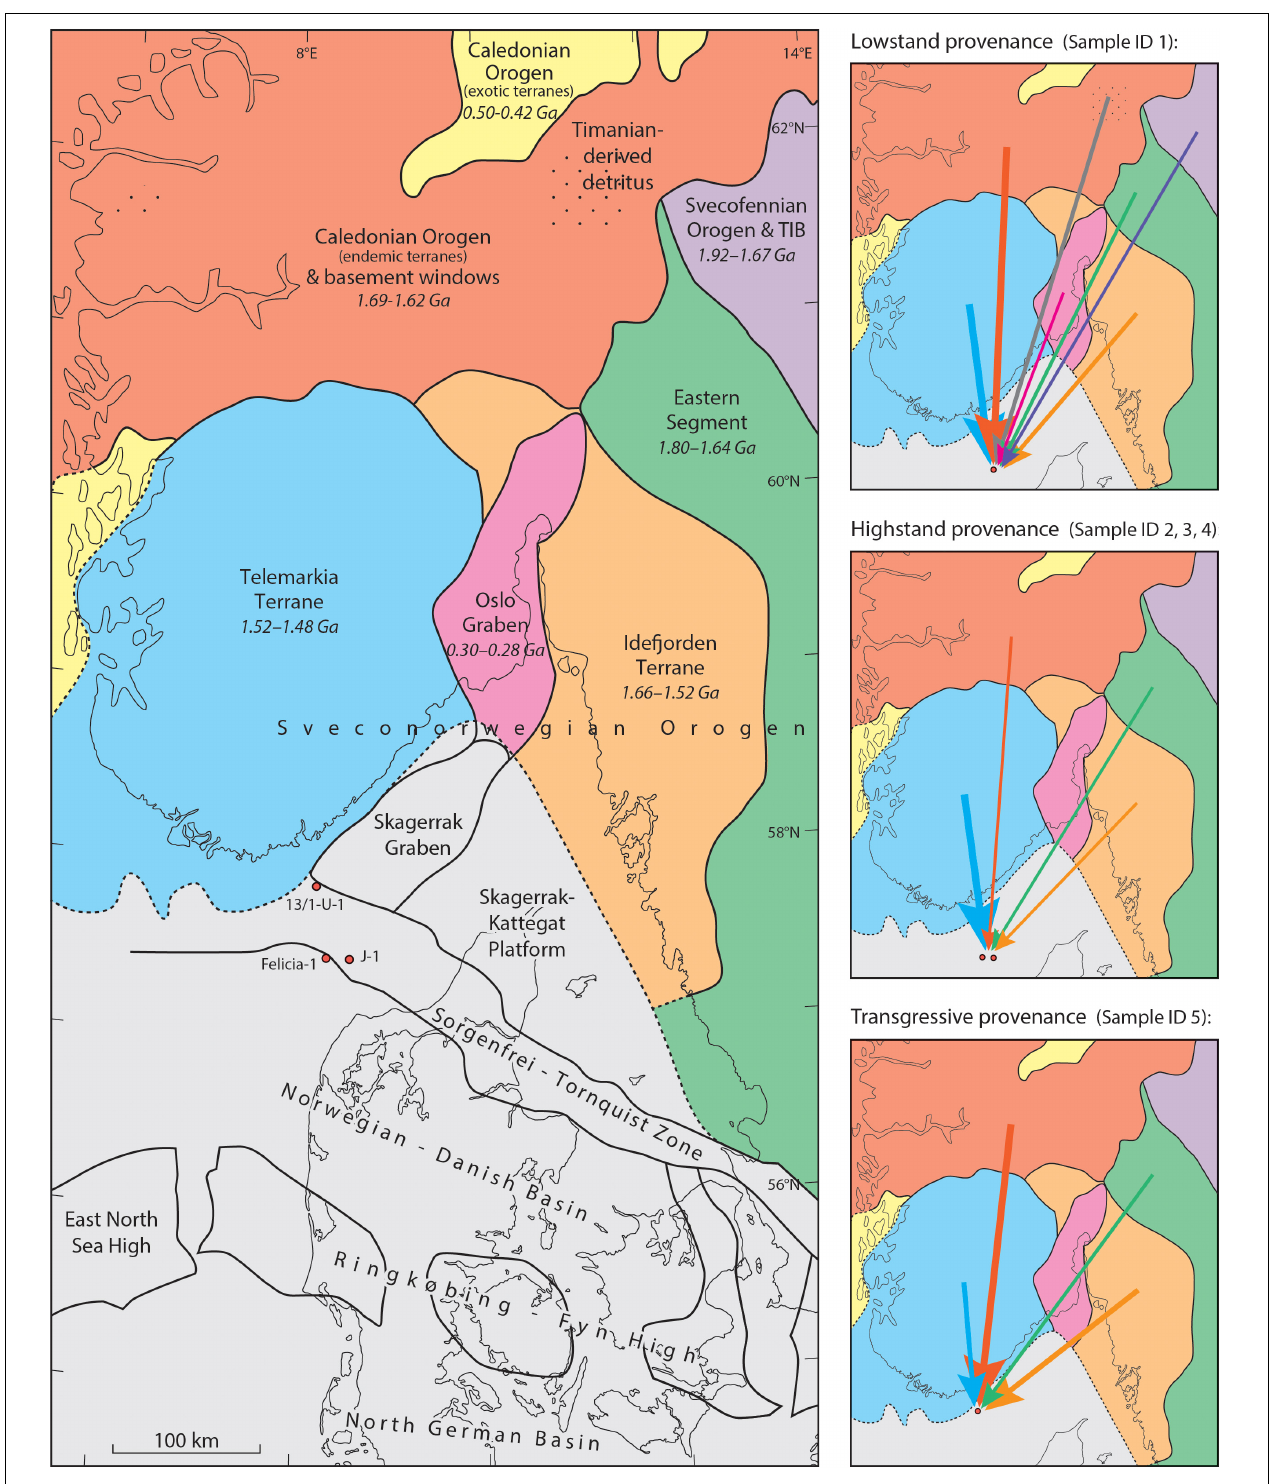
FIGURE 12 | Structural configuration of southern Scandinavia with the area of Triassic deposition shown in gray and indication of magmatic zircon ages of the major basement provinces in billion years (Ga). The map is based on Nielsen (2003), Heeremans and Faleide (2004), Lahtinen et al. (2008), Bingen and Solli (2009), Erlström and Sivhed (2012), Jarsve et al. (2014), and Slama (2016). The provenance interpretations are shown on the miniature maps where the thickness of the arrows is an indicator of the relative amount of sediment supplied from each terrane.